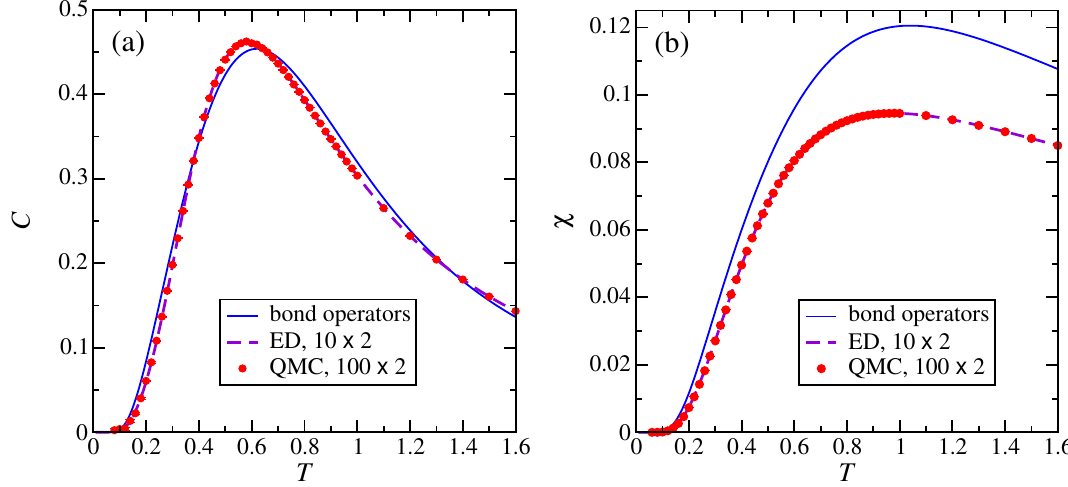
Figure 9: Magnetic specific heat, C , and susceptibility, χ , shown per spin for a partially frus- trated ladder with rung coupling J ⊥ = 1.45, leg coupling J (cid:107) = 1, and diagonal coupling J × = 0.2. We compare QMC results obtained for ladders of L = 100 rungs with ED results for L = 10 and the bond-operator result for a corresponding unfrustrated ladder with J ⊥ = 1.45 = and effective leg coupling J (cid:107) ,eff